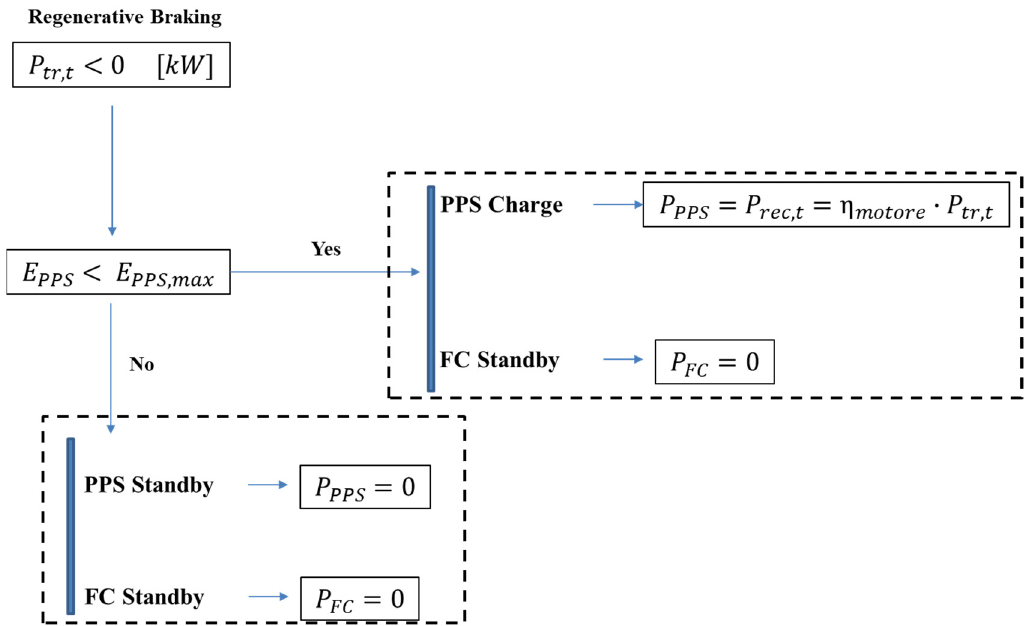
Figure 9. Regenerative Braking